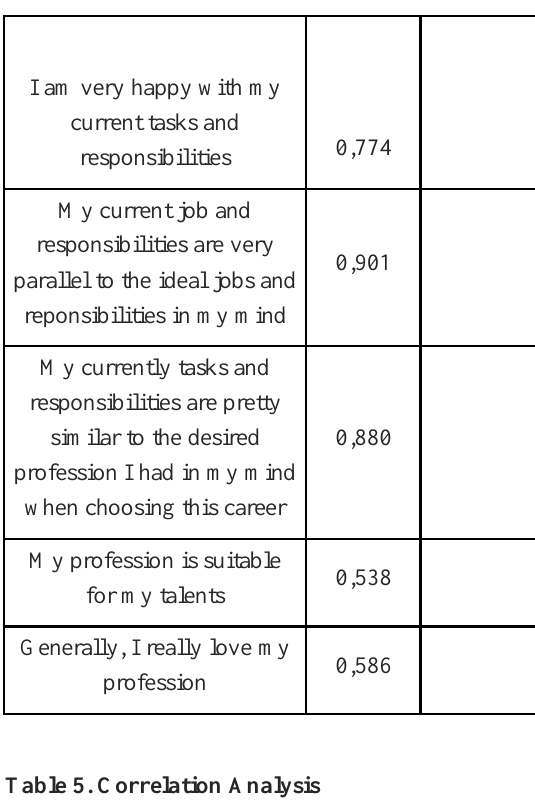
Table 5. Correlation Analysis